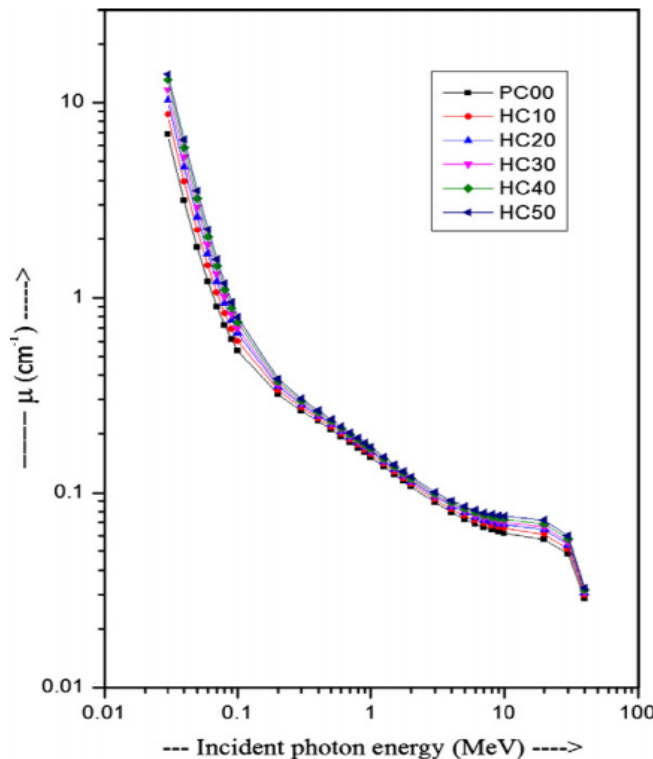
Figure 11. Variation of attenuation coefficient with photon energy for various samples [81]. Anno- tations: Hematite proportion: 50% (HC50), 40% (HC40%), 30% (HC30), 20% (HC20), and 10% (HC10).